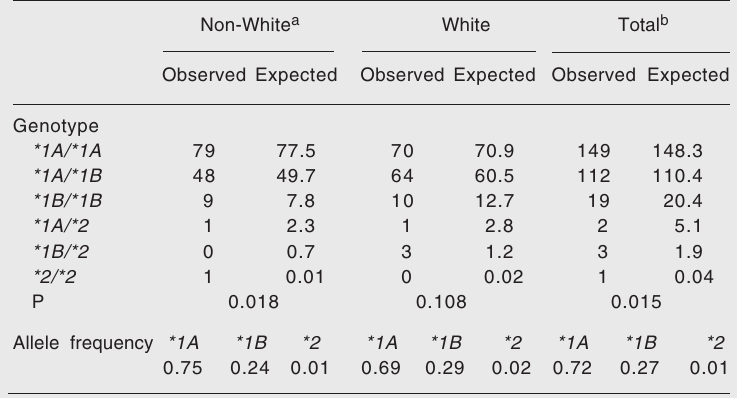
Table 4. CYP2A6 genotypes and allele frequencies in white and non-white Brazilian